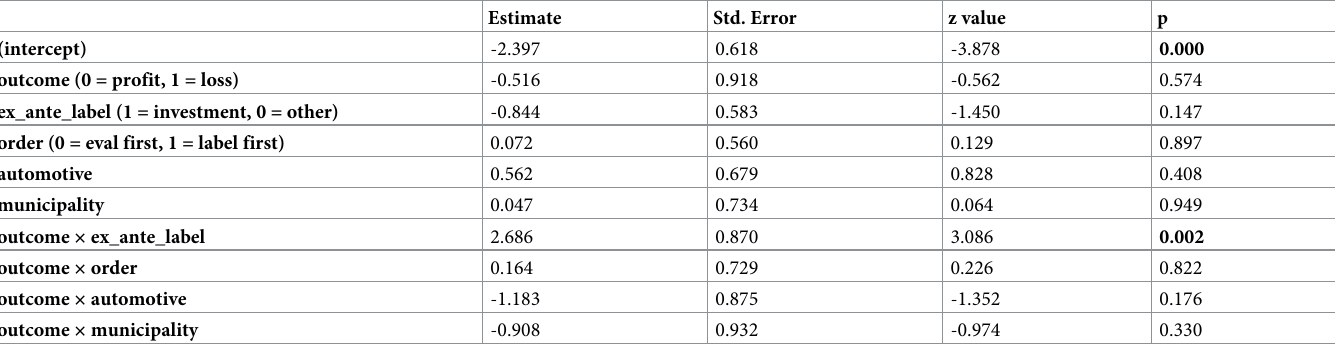
Table 11. Logistic regression with a dummy for label change as dependent